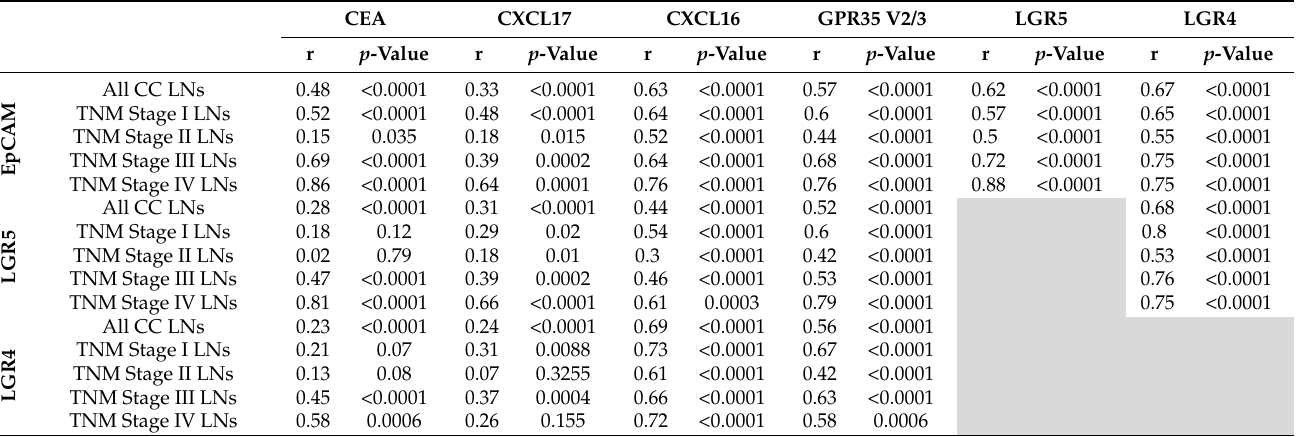
Table 1. Correlations between mRNA expressions of different markers in the lymph nodes of colon cancer